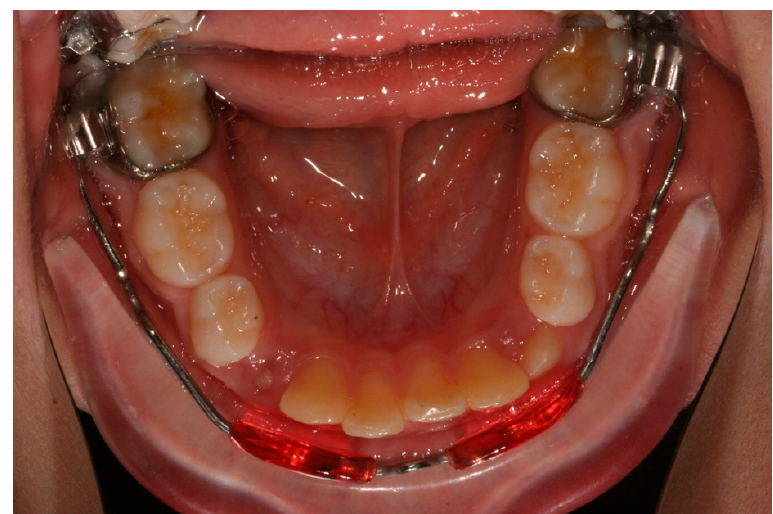
Figure 1. Lip bumper appliance.